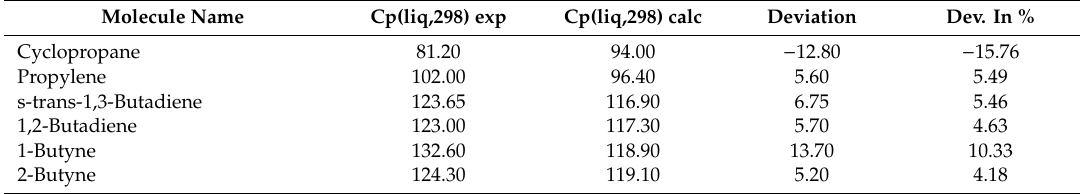
Table 5. Experimental and Equation (2)-calculated Cp(liq.298) of 222 hydrocarbons in J / mol /